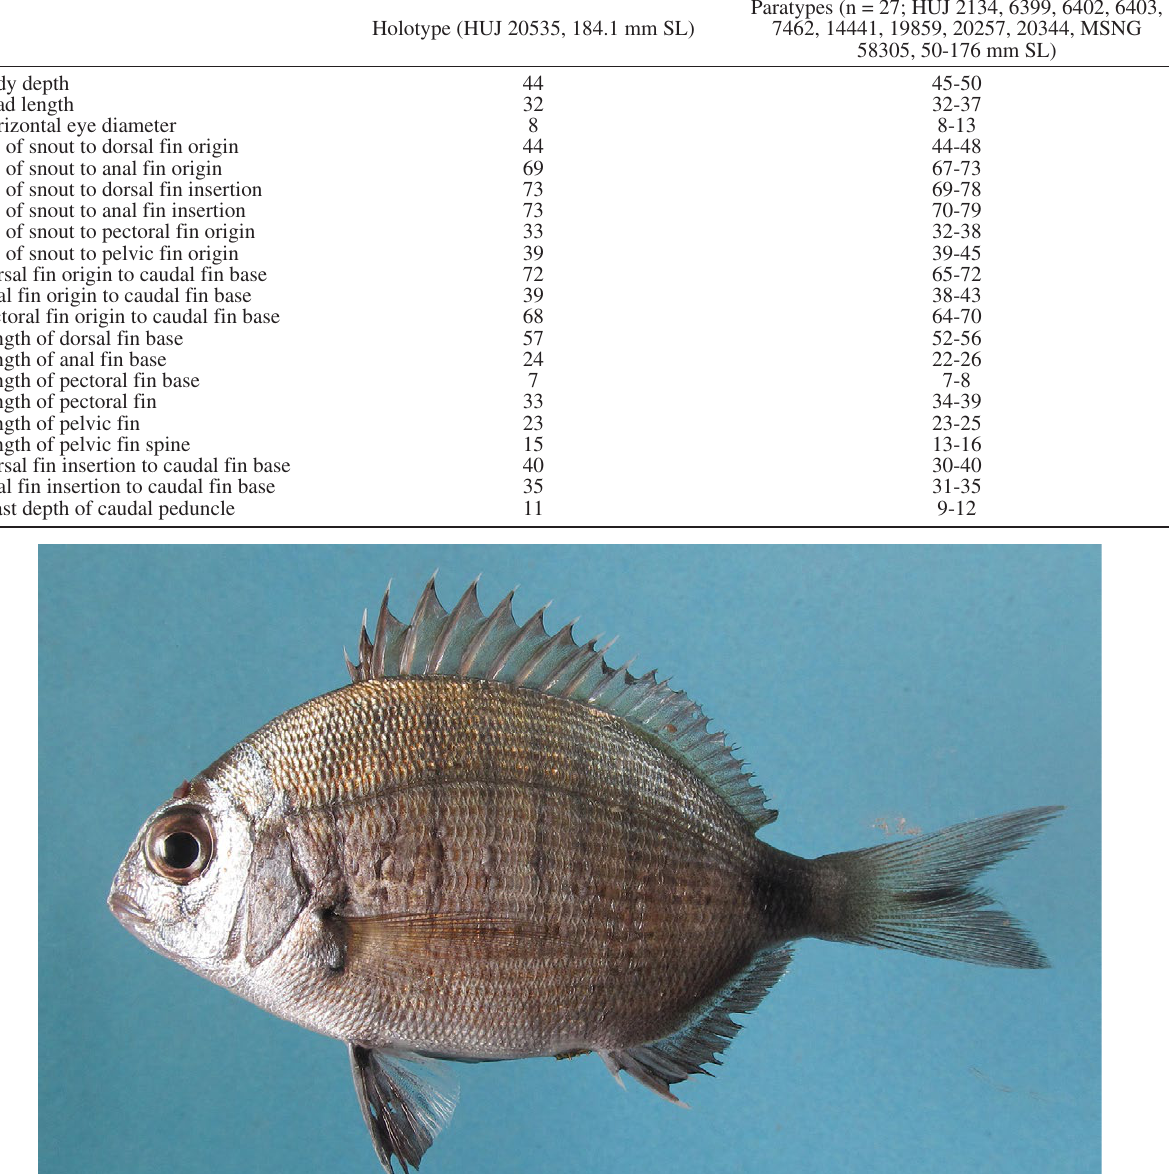
Table 1. – Selected body proportions of the holotype and selected paratypes of Diplodus levantinus n. sp., expressed in percentage of standard length.